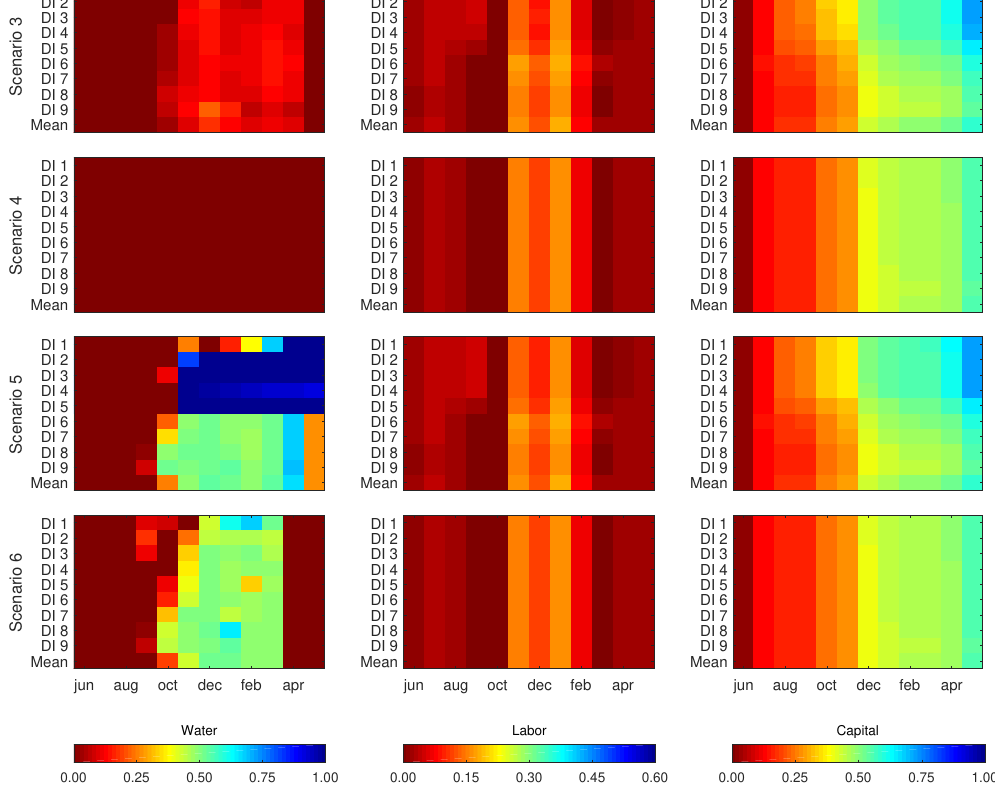
Figure 10. Monthly limiting resources presented as water, labour, and capital availability for each decile of water supply (DI) and for each monthly scenario (from 3 to 6) for situation a (see Section